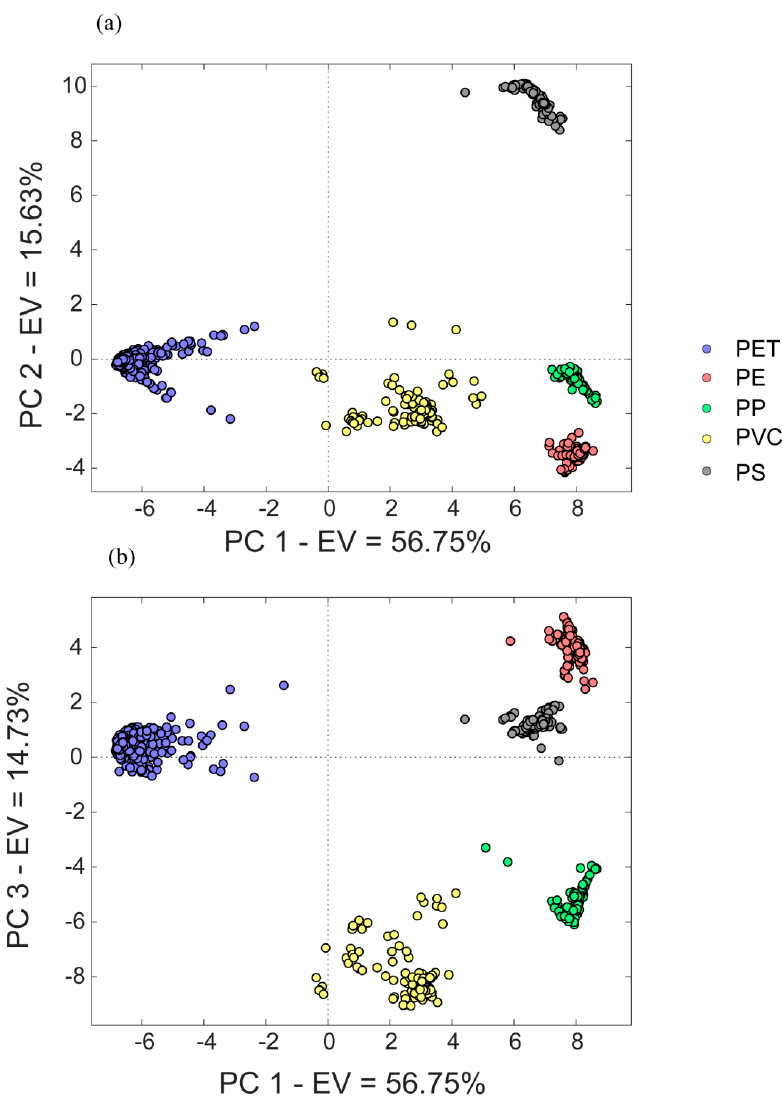
Figure 3. Results of principal components analysis carried out with spectral data of the different commodities. ( a ) The score plot of the first two components is shown, as well as ( b ) the score plot of PC1 vs. PC3 EV: explained variance.